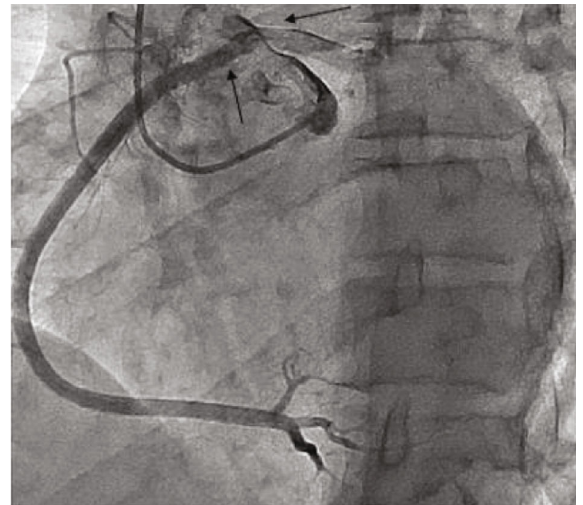
Figure 3: Coronary angiography revealing no atherosclerosis and the anomalous right coronary artery (left arrow) close to the origin of the left coronary artery (right arrow); with inter-aortico- pulmonary high-risk